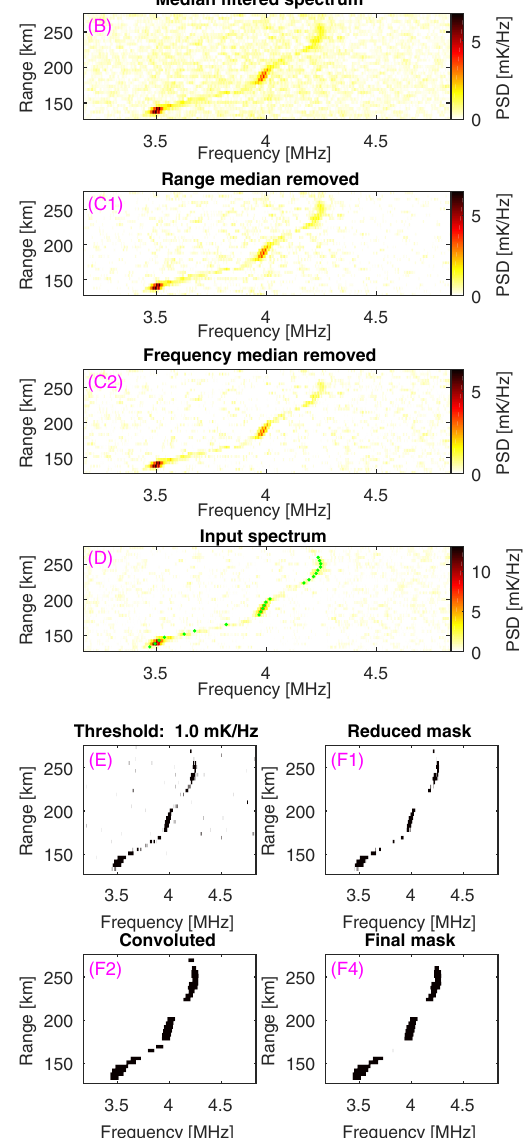
Figure 1. Example of reduction of plasma line data from 17 June 2007 at